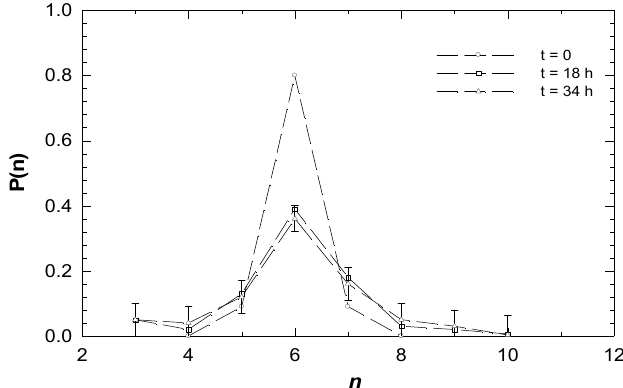
Figure 4. Topological class distributions as an example of an evolving wet foam containing an incommensurate grain boundary ( θ = 0).